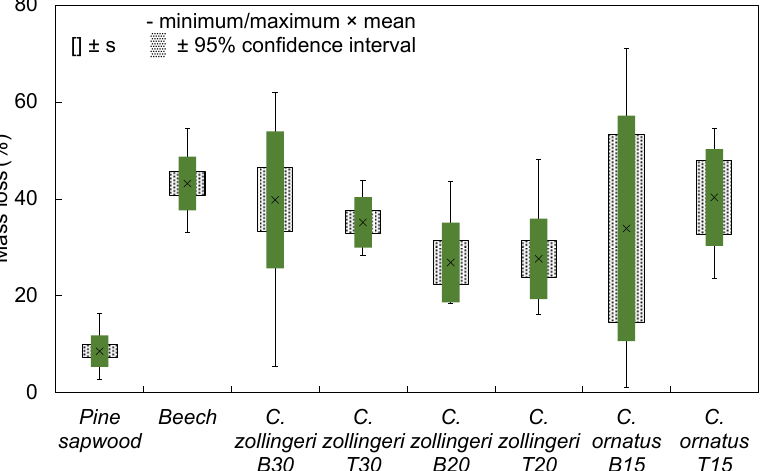
Figure 5. Mass loss of bottom/mature (B) and top/juvenile (T) rattan samples of different diameter classes (30, 20, and 15 mm) after decay test with the white-rot fungus Trametes versicolor . As white-rot decay has a common feature of degrading lignin, cellulose, and hemi- celluloses, the resistance of lignocellulosic material to this fungus highly depends on the relative proportion of their compositional polymers, i.e., it depends on the lignin content, carbohydrate ratio, and lignin monomer composition (mainly guiaicyl lignin) [42–44]. High mass loss of C. ornatus samples compared with the other rattan samples could be related